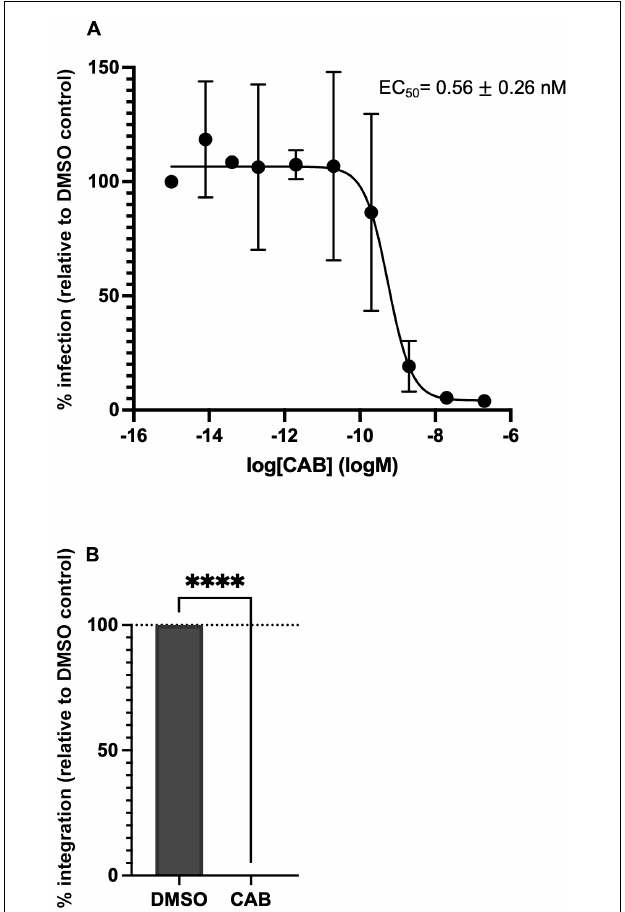
FIGURE 2 | Cabotegravir potently blocks HTLV-1 infection and integration in tissue culture. (A) Infection was quantified by measuring the PVL of INSTI treated cells compared to DMSO treated cells arbitrarily set at 100%. Averages and standard deviations of four independent experiments are shown. (B) Integrated provirus of DMSO and 200 nM CAB (CAB) treated samples was quantified by Alu-qPCR and normalised to ALBUMIN numbers. Values are relative to DMSO control. Average and standard deviations of four independent experiments are shown; ∗∗∗∗ p -value <